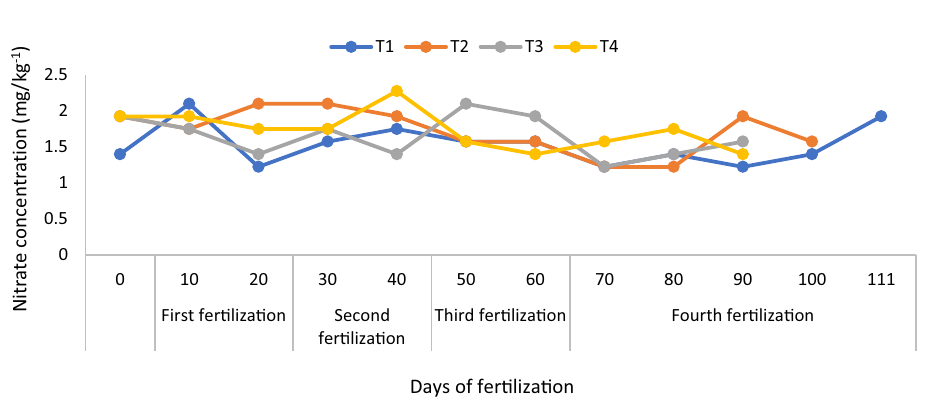
Figure 4. Improving soil nitrate content using chicken litter biochar in MR219 rice